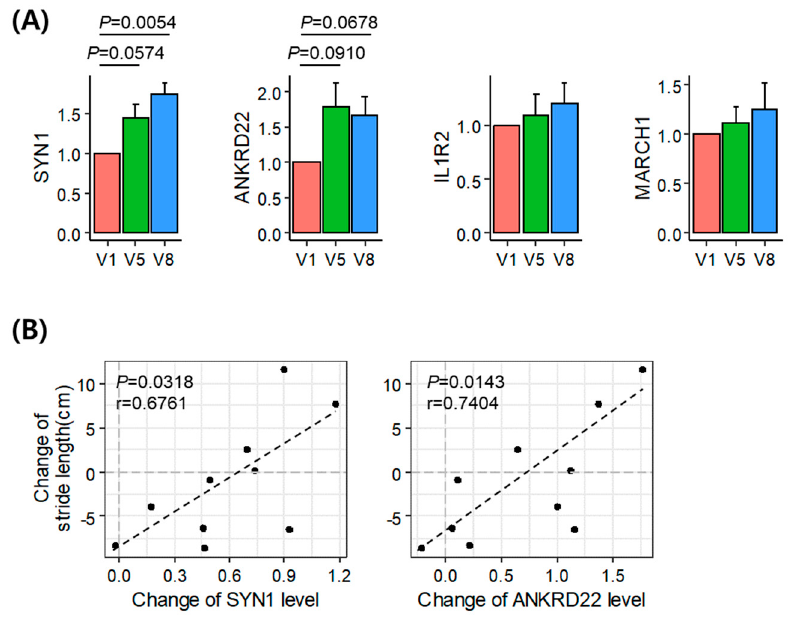
Figure 4. Experimental validation of the identified therapeutic marker genes. ( A ) Expression levels of the marker genes in the blood of five patients at V5 and V8 compared to V1. P -values were determined using the two-tailed paired t -test. ( B ) Correlation between changes in stride length and changes in SYN1 (left) and ANKRD22 (right) expression levels. The Pearson’s correlation coefficients ( r ) and P -values ( P ) indicate positive correlations. (It should be noted that results using Spearman’s rank-order correlation were less significant as P -value of 0.0667 and 0.0289 for SYN1 and ANKRD22, respectively).